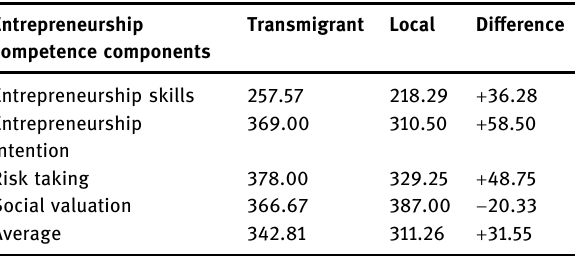
Table 10: Entrepreneurship competencies of poor